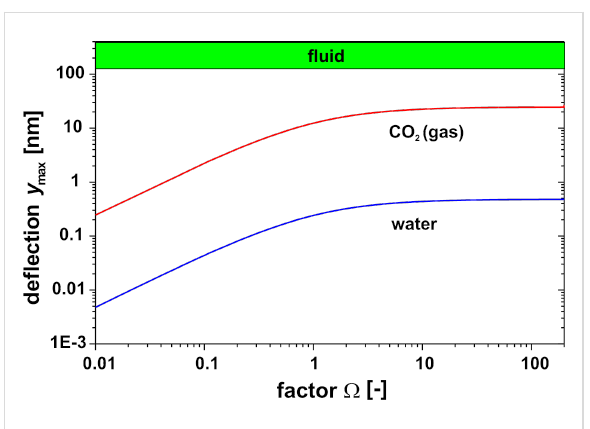
Figure 10: Maximum central deflection y max of a circular membrane at t = 0.5 s as function of factor Ω for a water-filled and CO 2 -filled cavity. IR power density 10 W/m 2 , diameter and height of the cavity: 0.5 mm.